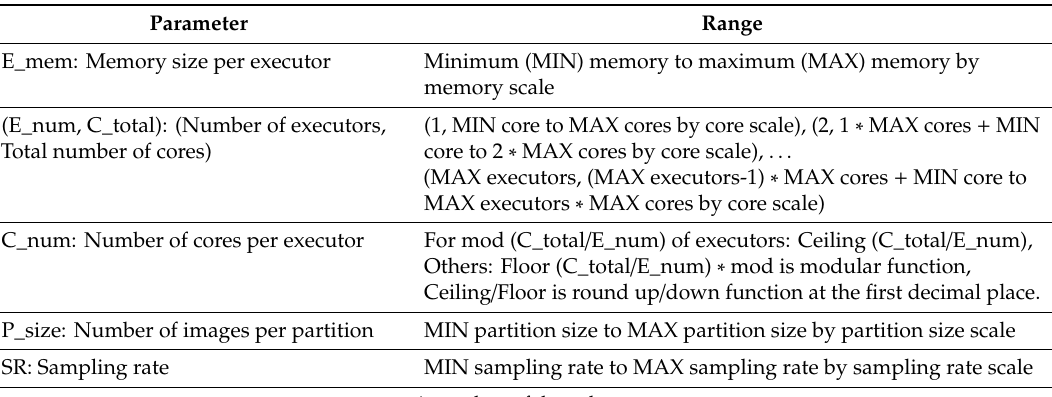
Table 7. Definition and range of all features.